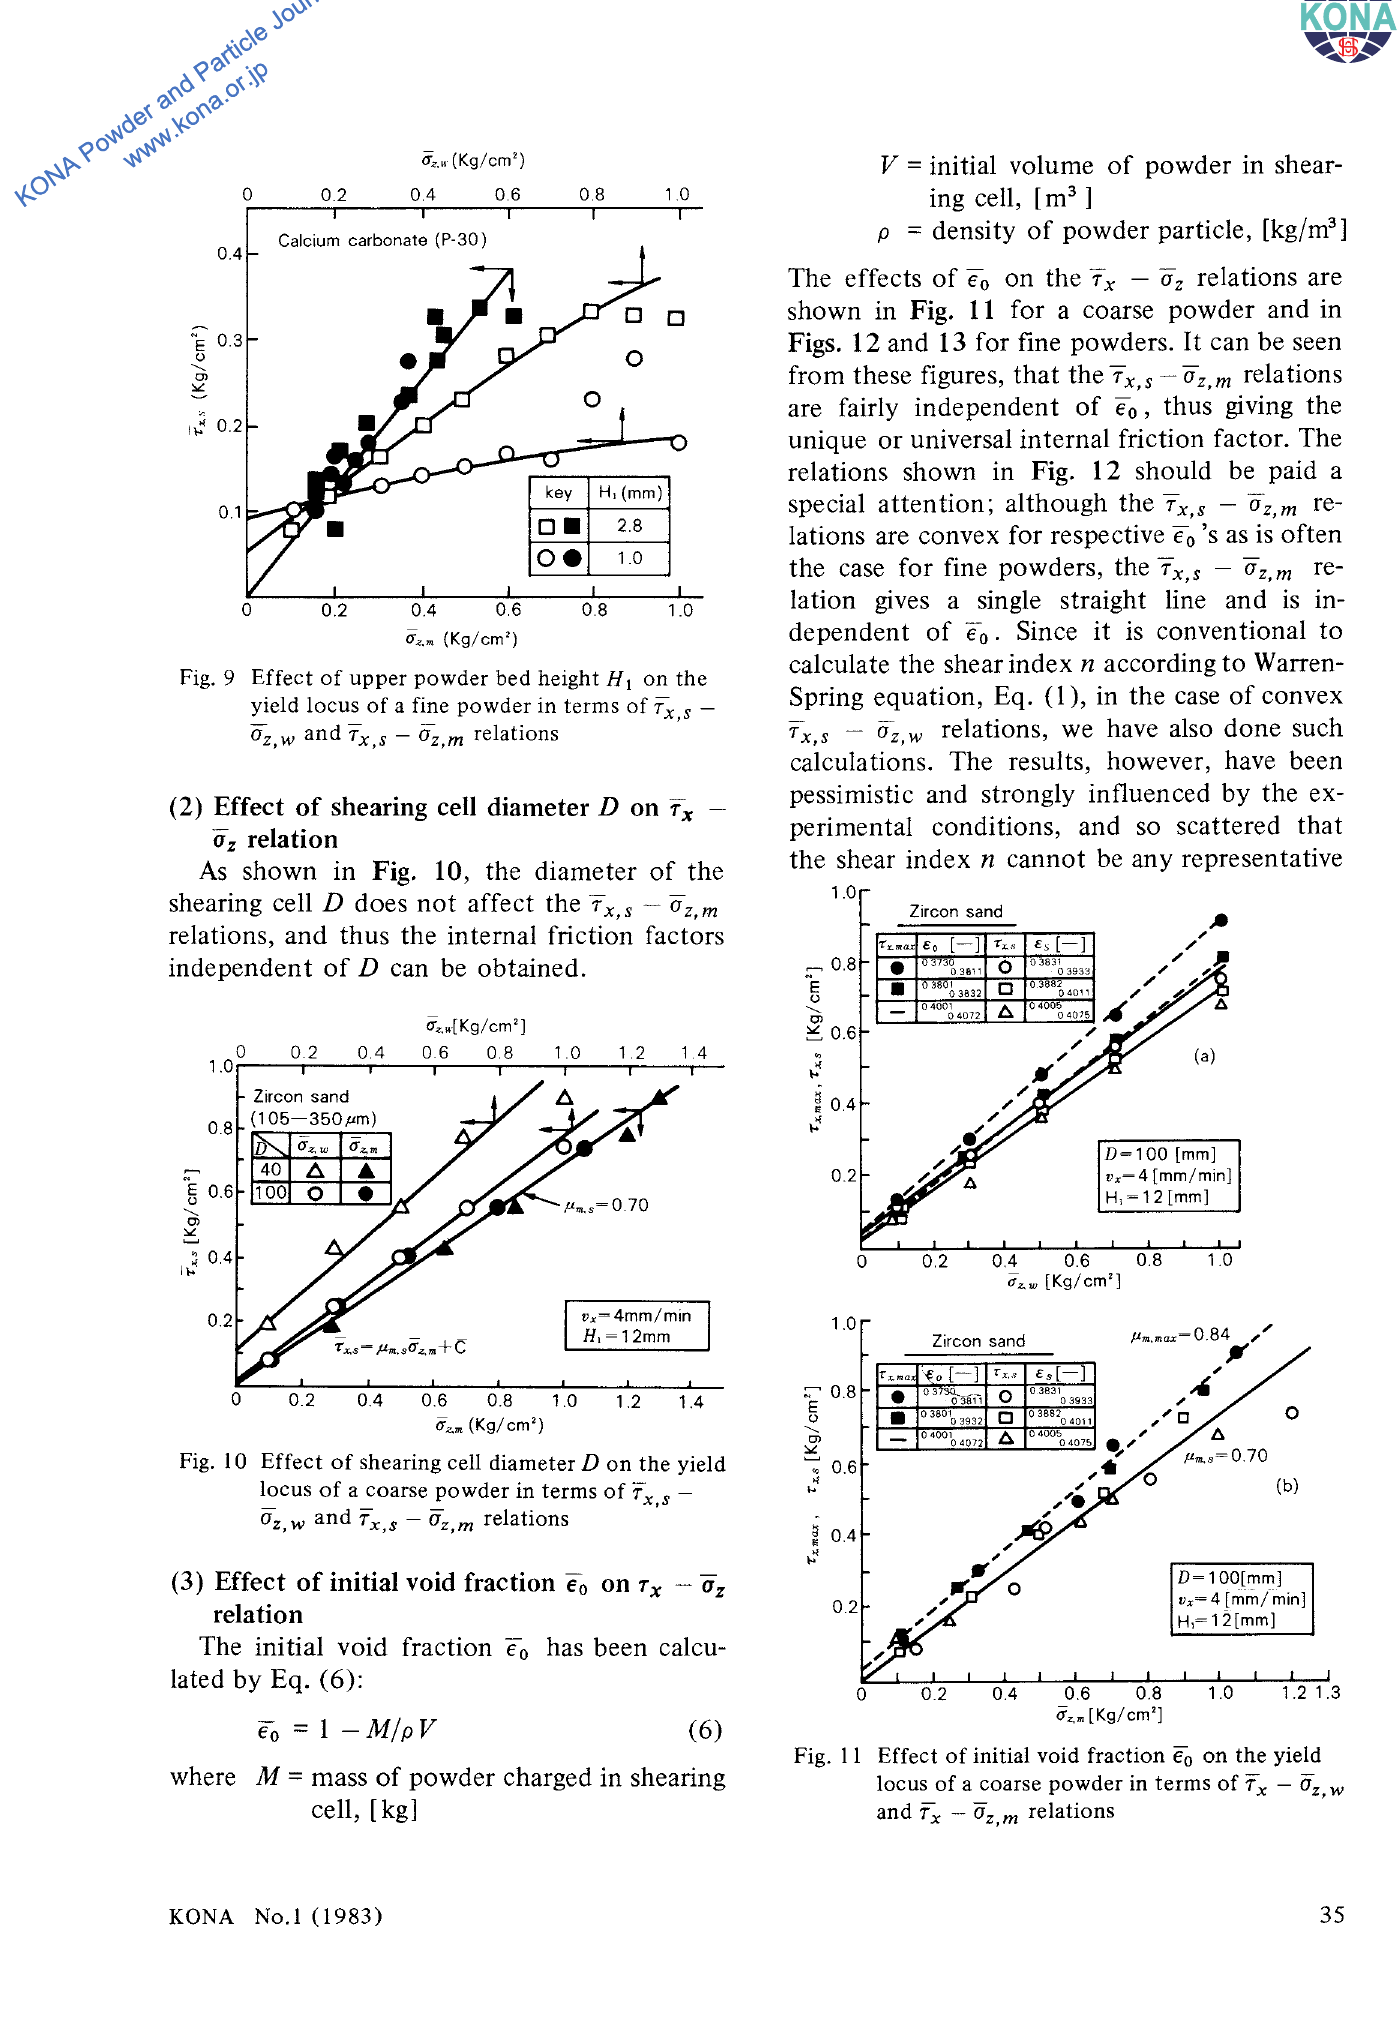
Fig. ll Effect of initial void fraction e 0 on the yield locus of a coarse powder in terms of Tx - Oz, w and Tx - Oz,m